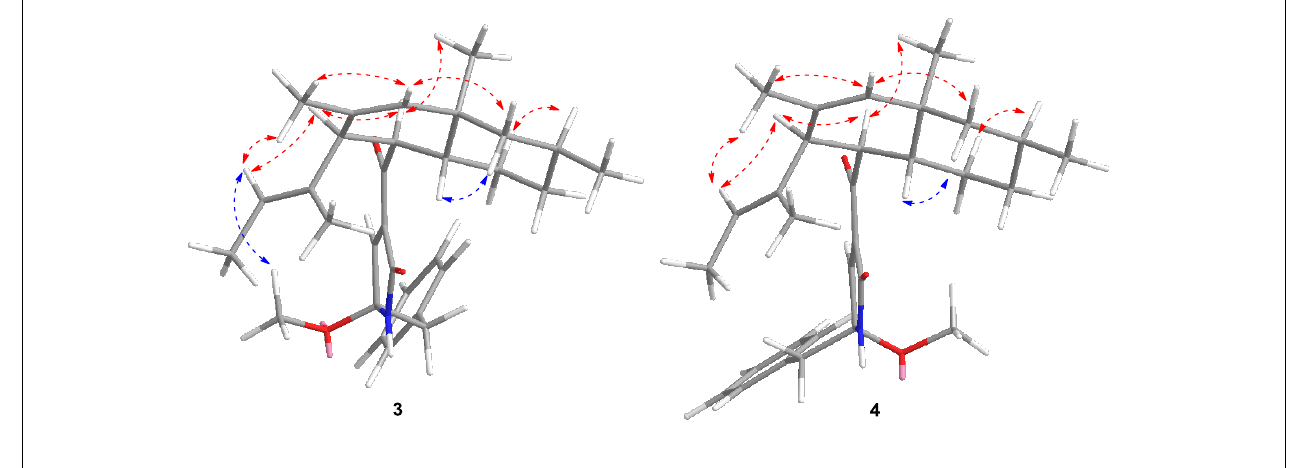
FIGURE 5 | Key NOESY correlations of 3 and 4 .